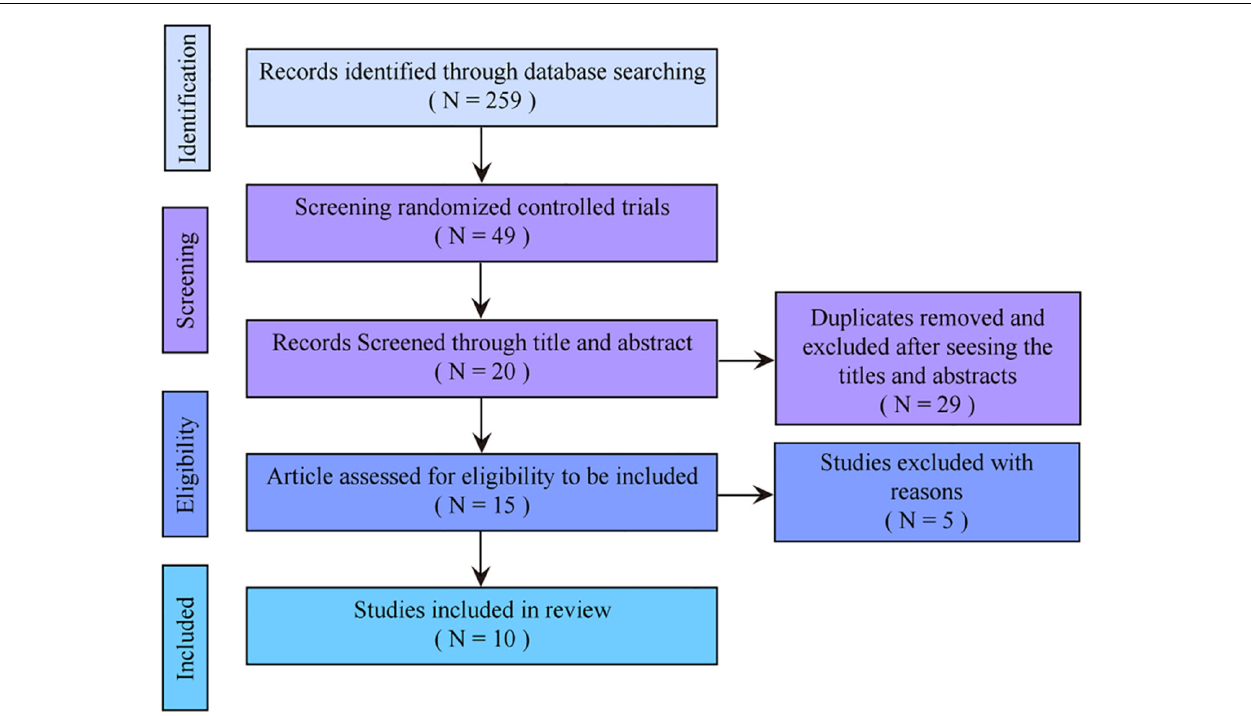
FIGURE 1 | Study flow